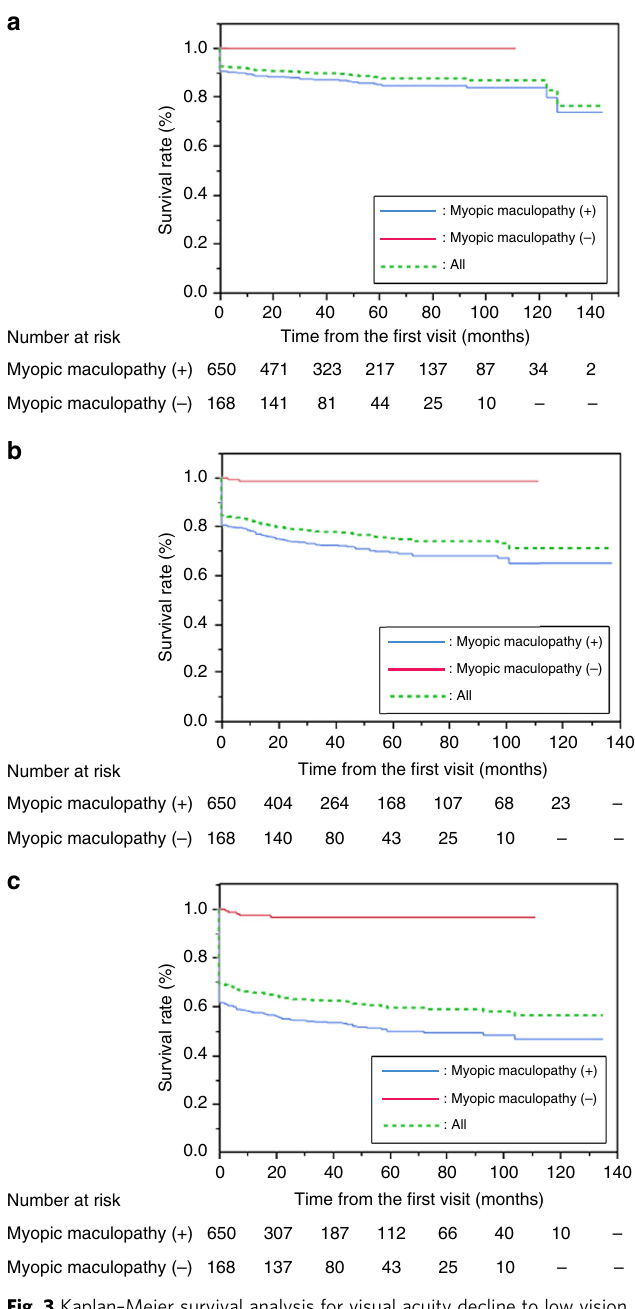
Fig. 3 Kaplan – Meier survival analysis for visual acuity decline to low vision and blindness among highly myopic patients according to myopic maculopathy grade. Visual acuity decline to ( a ) 1/20, ( b ) 1/10, and ( c ) 3/10 was observed with a higher frequency in patients with myopic maculopathy grades 2, 3, and 4 at